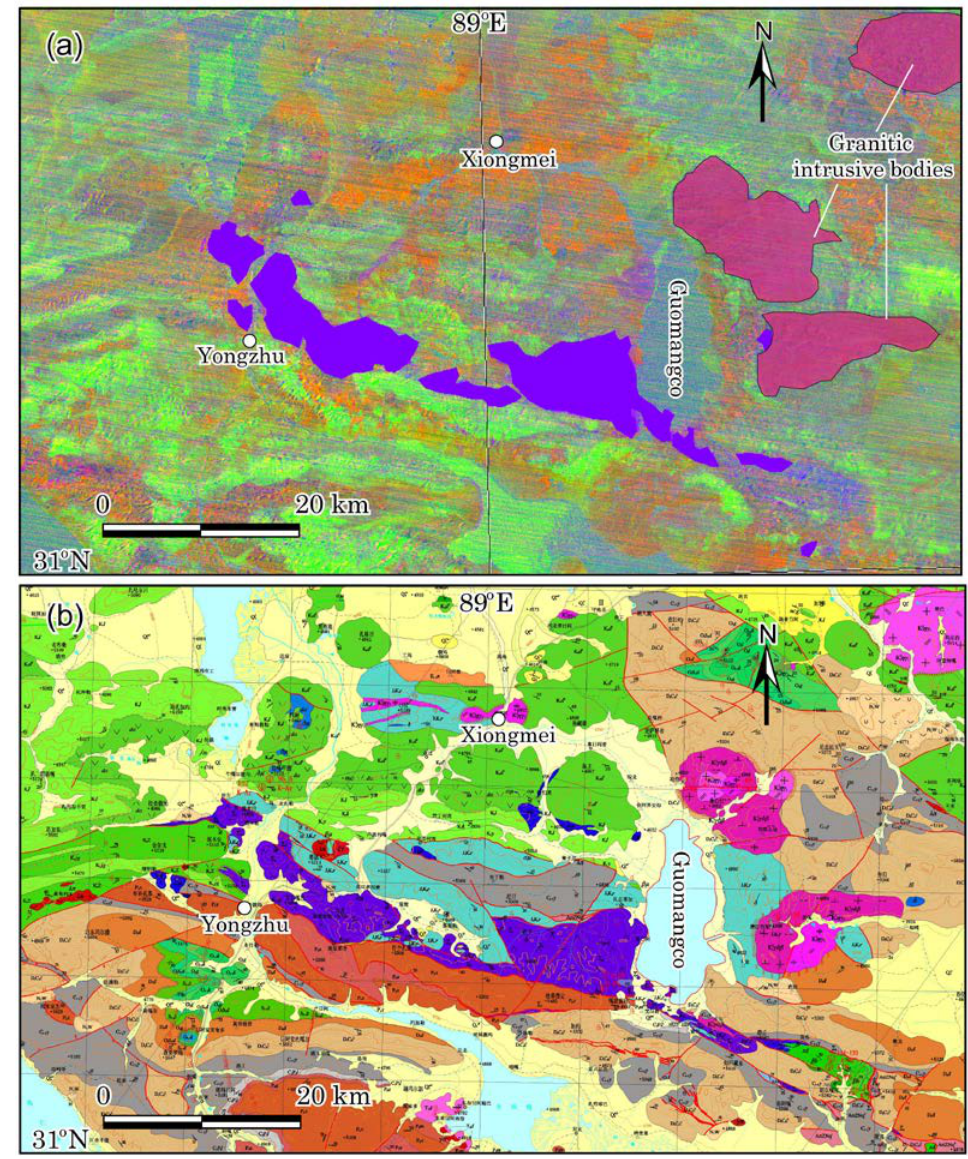
Figure 9. Comparison of ( a ) the Yongzhu-Guomangco ophiolite map (the polygons colored purple; enlarged from Figure 8) and the map of the granitic intrusive bodies (the polygons colored reddish purple) derived in this study using ASTER TIR data superimposed on the color composite image of the indices (Figure 4) with ( b ) the published geological map based on the field investigations (e.g., [39,40]). The coverage of this figure is shown as the red rectangle in Figure